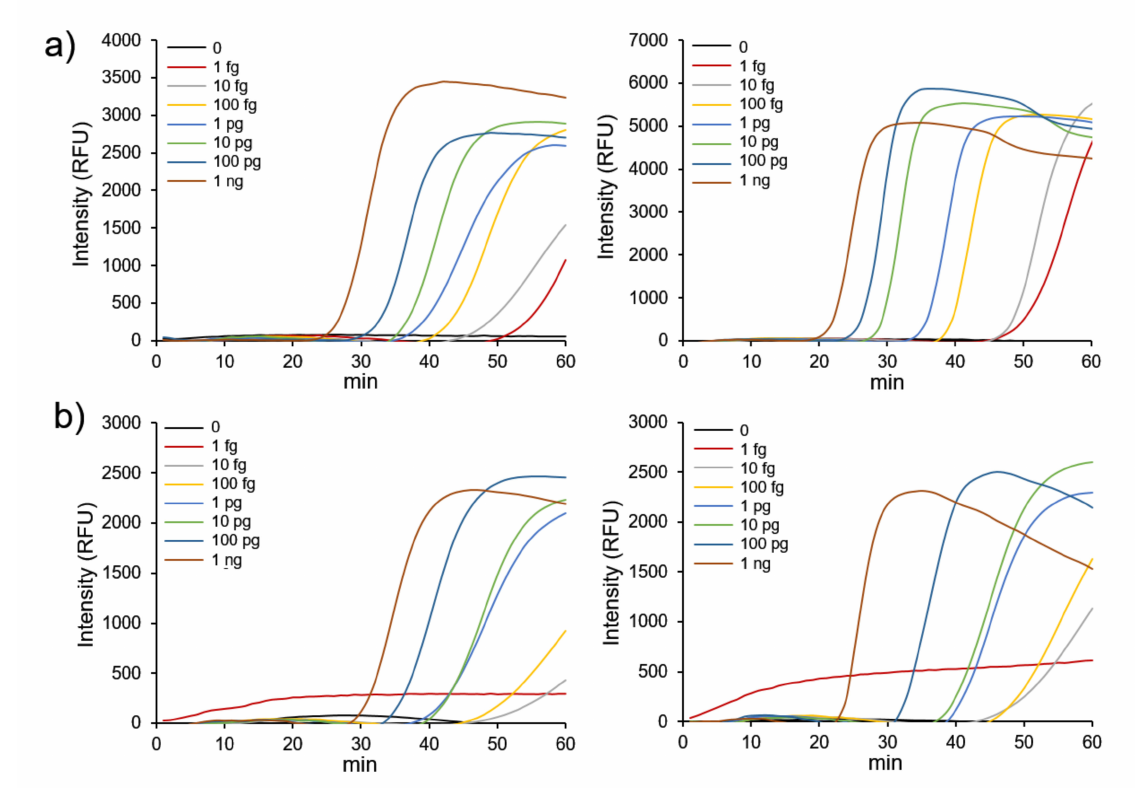
Figure 3. Effect of foot-and-mouth disease virus (FMDV) gene concentration on the loop-mediated isothermal amplification (LAMP) reaction using FMDV genes. Real-time fluorescence monitoring of the LAMP reaction using ( a ) FMDV serotype O and ( b ) FMDV serotype A genes. Left and right panels, graphene oxide (GO), and GO–AuNPs (AuNPs@GO) nanocomposite,